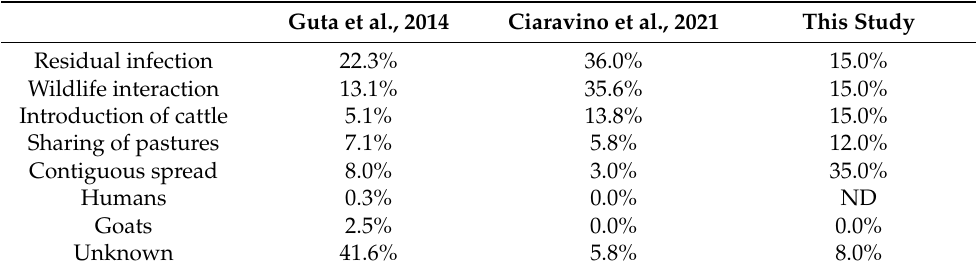
Table 6. Comparison of most likely causes of bovine TB breakdowns in Spanish herds. Guta et al., 2014 Ciaravino et al., 2021 This Study